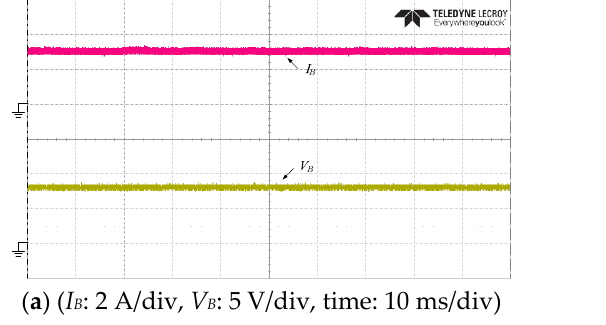
Figure 16. Measured battery voltage V B and current I B waveforms: ( a ) under I B = 3 A and ( b ) under I B = 6 A when V PV = 36 V. Table 6. Key components of the proposed hybrid converter.